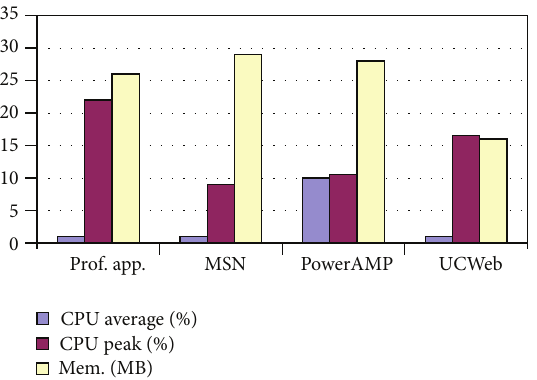
Figure 5: CPU/memory utilization.